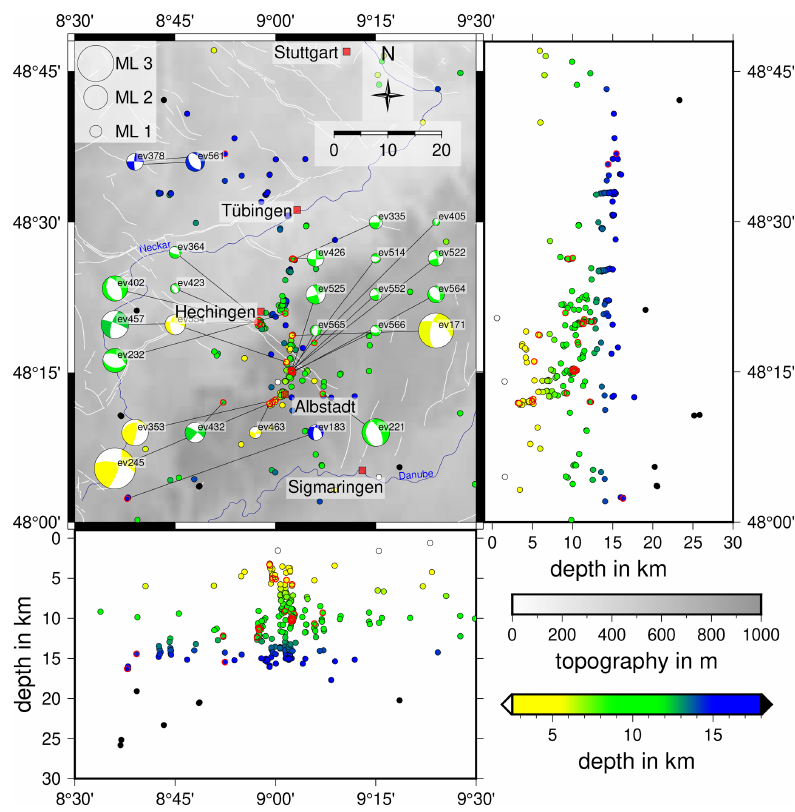
Figure 7. Hypocenters of the 337 best-located events with a horizontal error of less than 1km and a depth error of less than 2km. Only events with a GAP smaller than 180 ◦ and more than eight travel time picks are included. Hypocenters are plotted as circles that are color-coded by depth. All 25 focal mechanisms are displayed also color-coded by depth; red circles indicate the corresponding event hypocenter. The size of the focal mechanisms is scaled depending on ML of the event. Cluster codes are placed next to the fault plane solutions. White lines indicate known and assumed faults (Regierungspräsidium Freiburg, 2019). Topography is based on the ETOPO1 Global Relief Model (Amante and Eakins, 2009; NOAA National Geophysical Data Center,